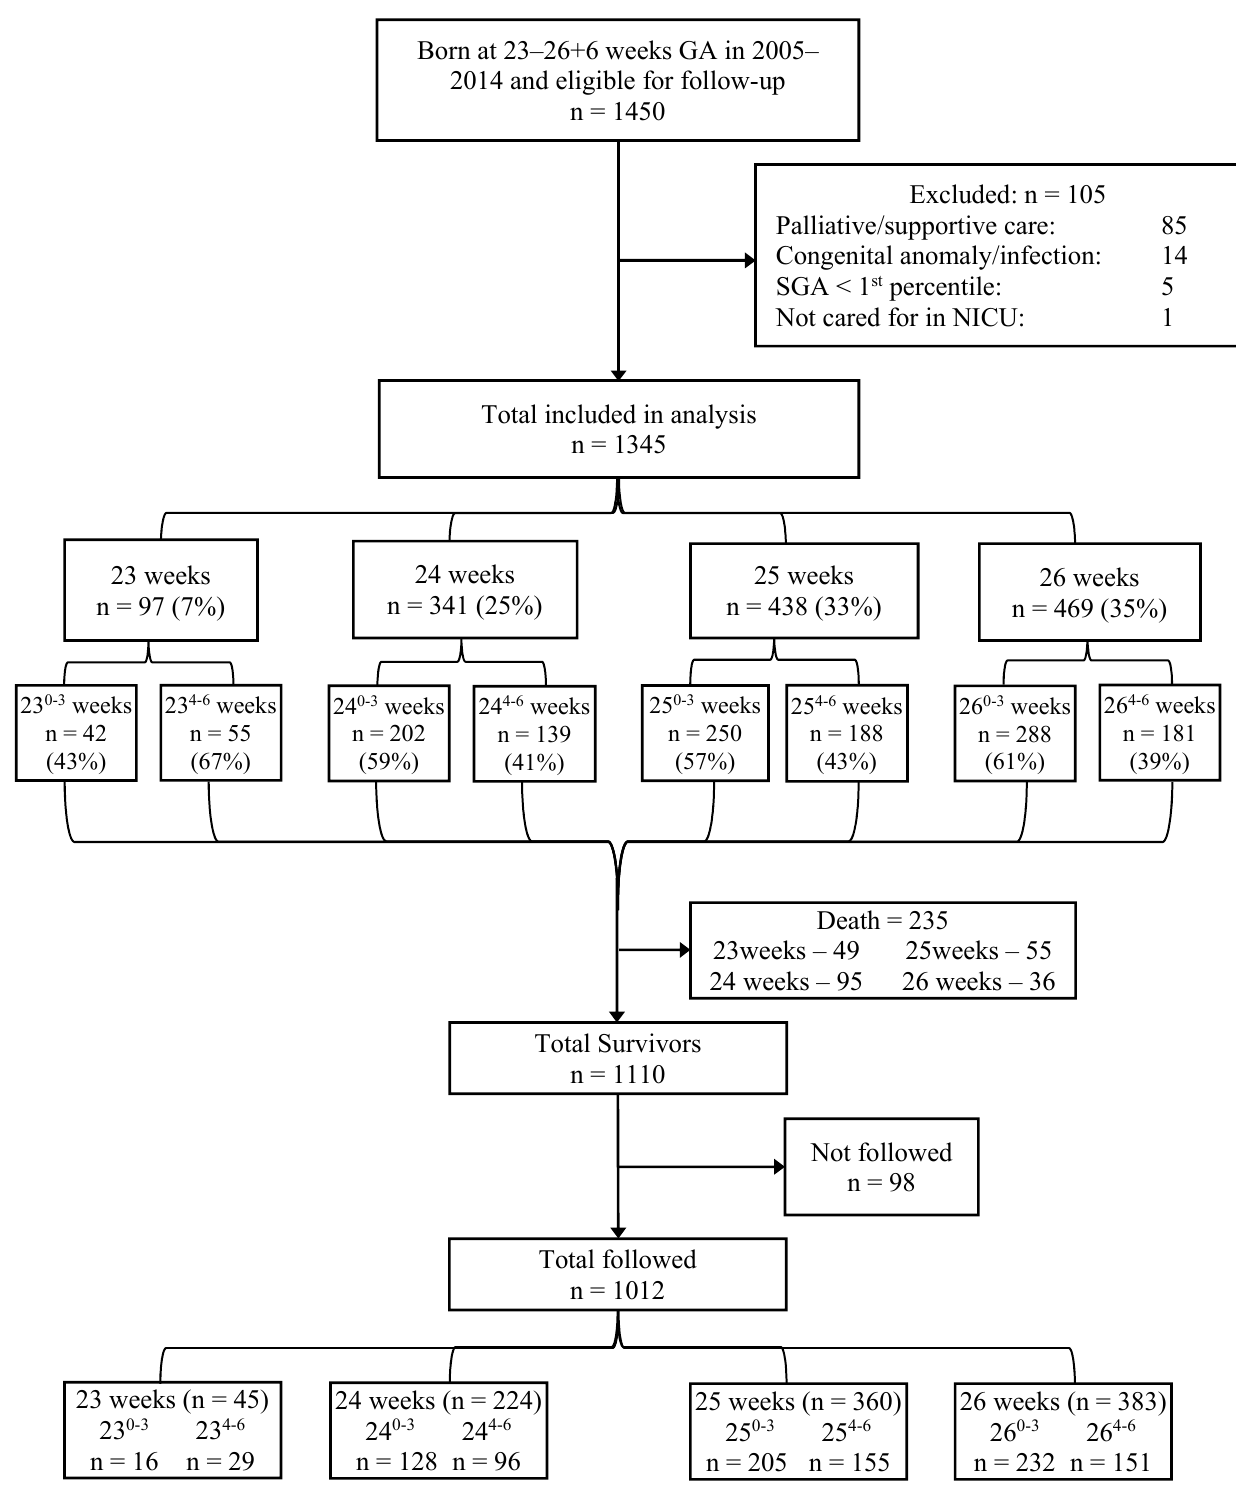
Figure 1: Flowchart of enrolled infants